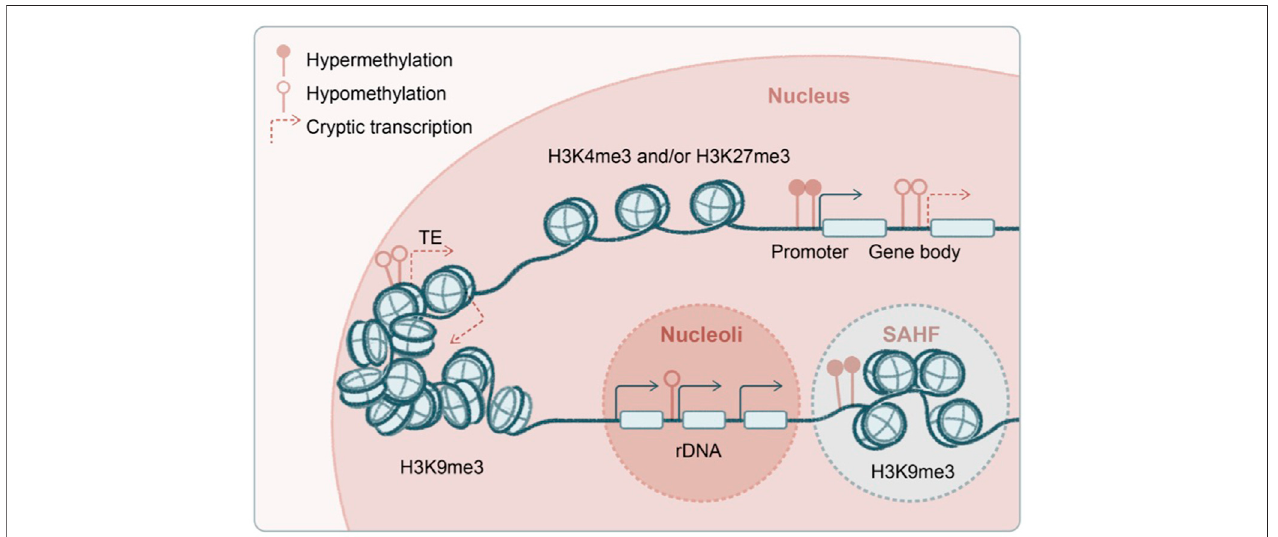
FIGURE 4 | Transcriptional and epigenetic noise in aging stem cells. Several proposed origins of the transcriptional and epigenetic noise in aged stem cells, including genome-wide hypomethylation and derepression of transposable elements, spurious transcription from the gene body, and deregulated transcription from ribosomal DNA (rDNA) at nucleoli. Global hypomethylation is accompanied by regional hypermethylation at gene promoters as well as formation of senescence- associated heterochromatin foci (SAHF). Some of the enzymes and post-translational histone modi fi cations have been shown to regulate aging and longevity in a transgenerational